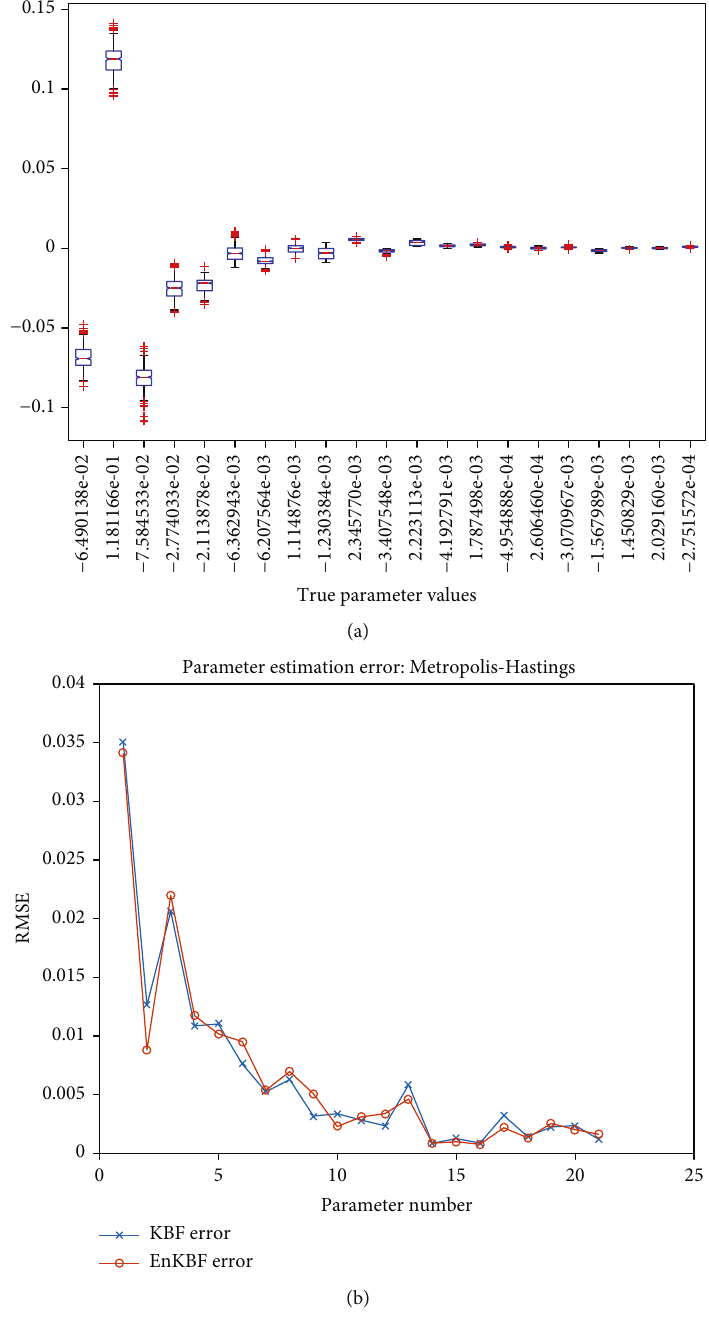
Figure 4: (a) Boxplot for the 21 velocity parameters for the EnKBF run for 1000 time steps with 1000 Metropolis-Hastings cycles. A burn-in of 500 parameter draws is discarded. The stochastic advection equation model is used with the following settings: L = 2 π , 100 grid points, δ t = 0 : 01 , M = 1000 particles, μ = 0 : 001 , and localization radius of 10 grid points. (b) A plot of the root mean square error for the 21 hyperparameter estimates obtained using EnKBF and KBF. The plot indicates that the performance of EnKBF matches that of KBF in this